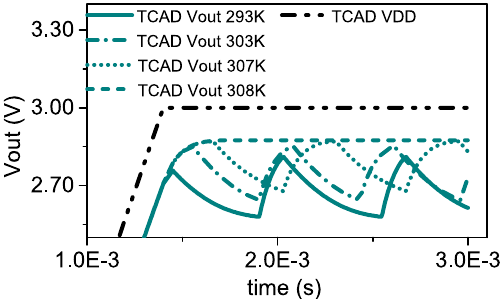
Figure 6. TCAD simulated voltage oscillations for V DD = 3 V, R ext = 15 k (cid:31) and C ext = 1.5 × 10 − 7 F, at external temperature of T 0 = 293 K (solid line), T 0 = 303 K (dash-dotted line), T 0 = 307 K (dotted line) and T 0 = 308 K (dashed line).